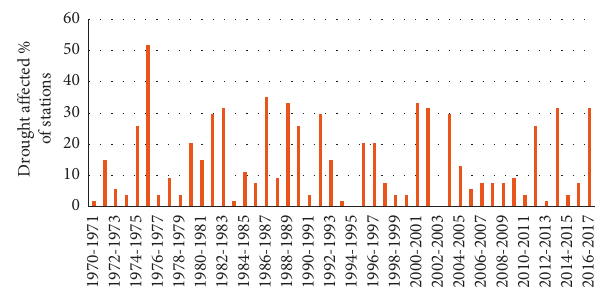
Figure 2: No. of stations (%)showing drought events in each hydrological year (1970 to